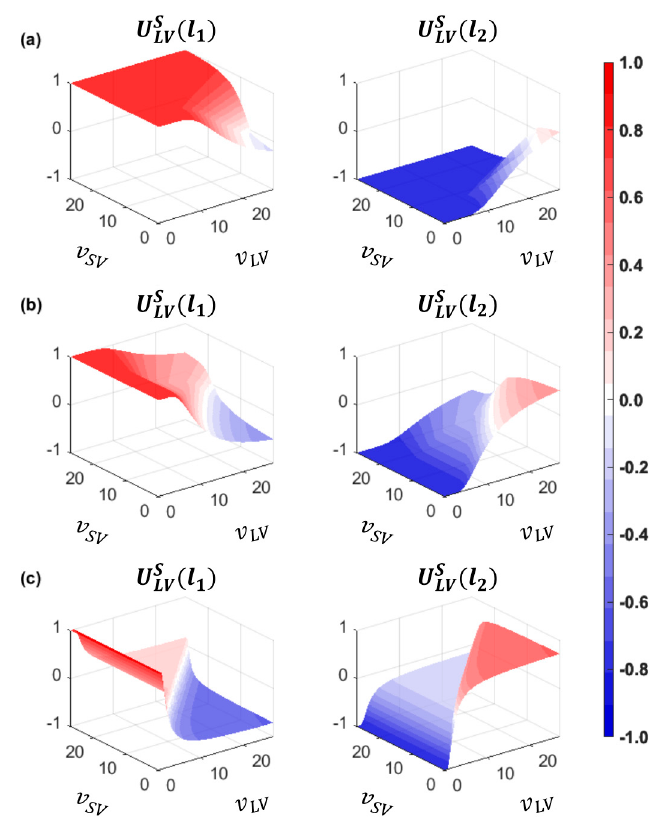
Figure 5. Safety payo ff s of the driver of LV for the l 1 and l 2 action: ( a ) close to the PV ( ∆ x SV , LV = 67 m, ∆ x PV , SV = 10 m); ( b ) middle position between PV and LV ( ∆ x SV , LV = 38 m, ∆ x PV , SV = 39 m); ( c ) close to the LV ( ∆ x SV , LV = 10 m, ∆ x PV , SV = 67 m ).